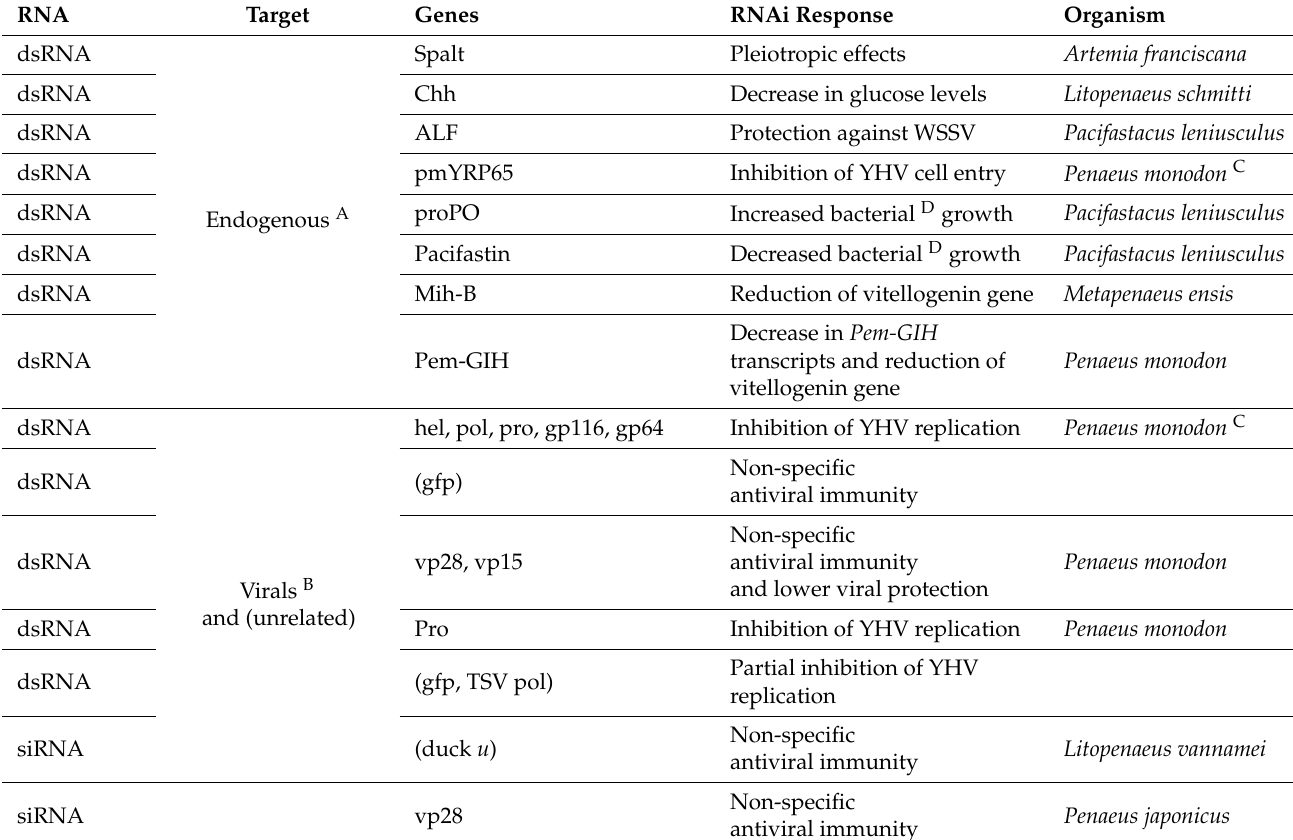
Table 3. Effective applications of the RNAi technique in crustaceans